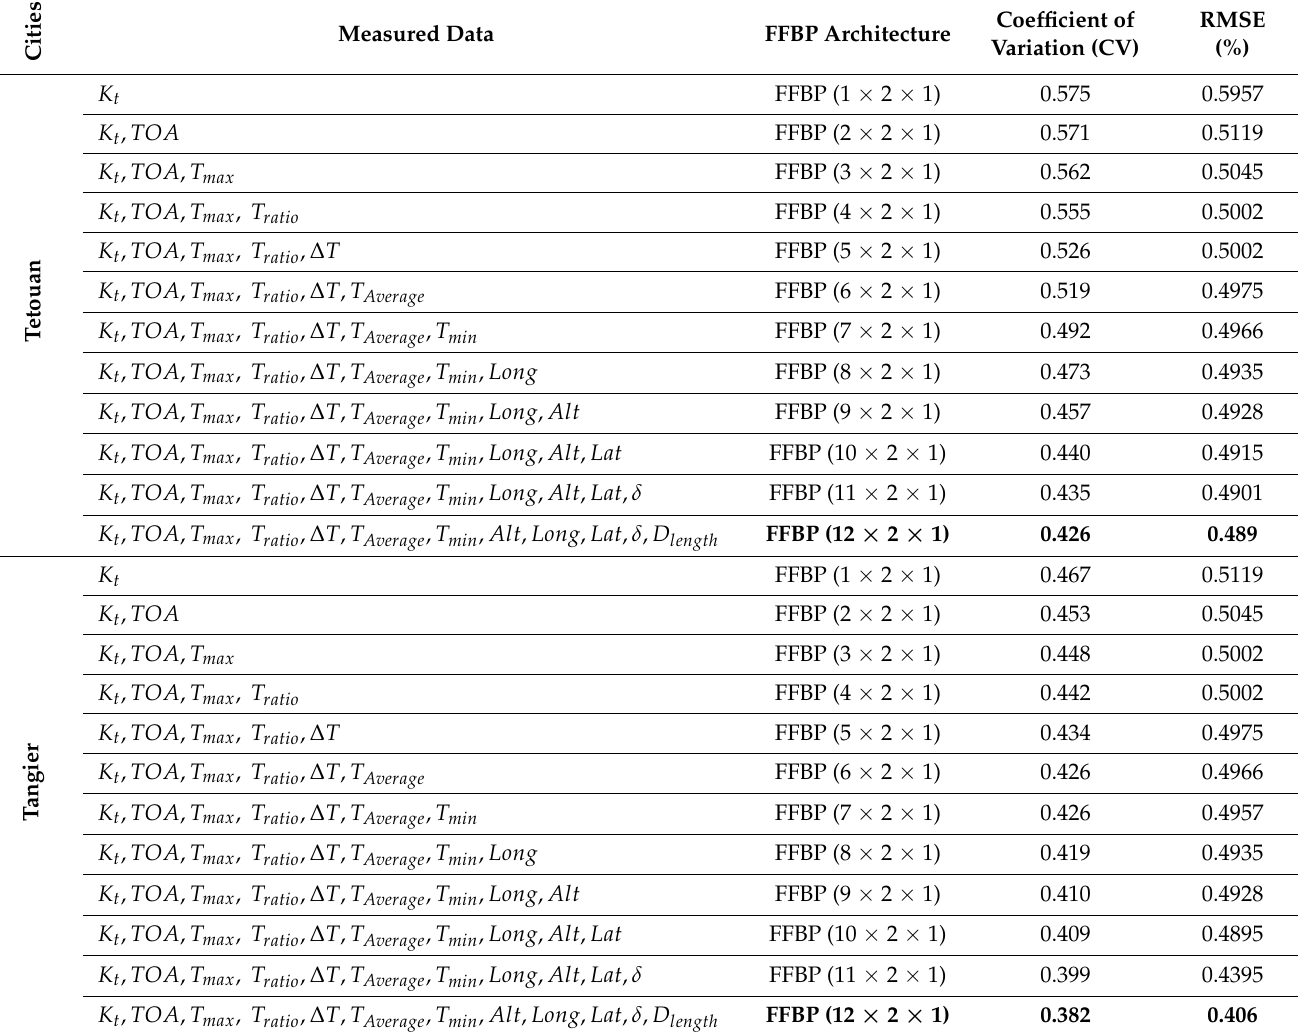
Table 5. Daily GSR forecasting models with multiple FFBP network